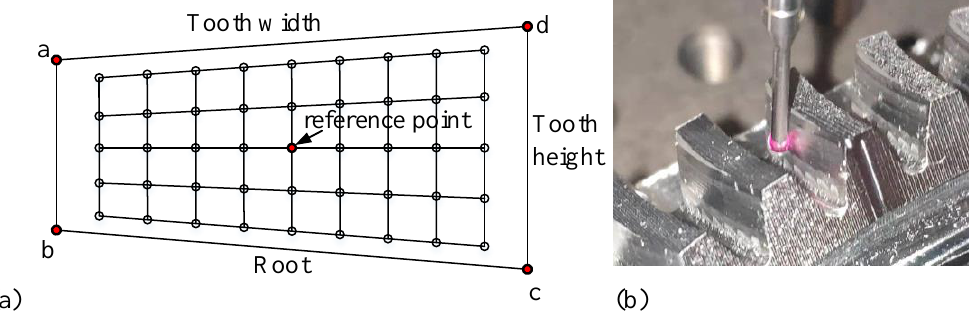
Figure 13. ( a ) Measurement mesh; ( b ) measuring tooth profile errors.